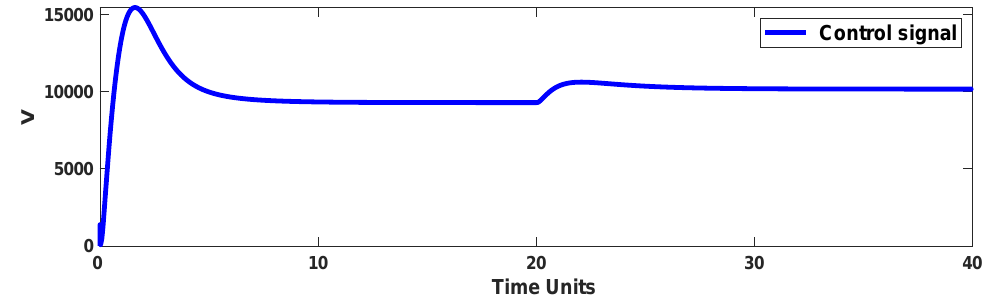
Figure 13. Control signal in the faulty condition.